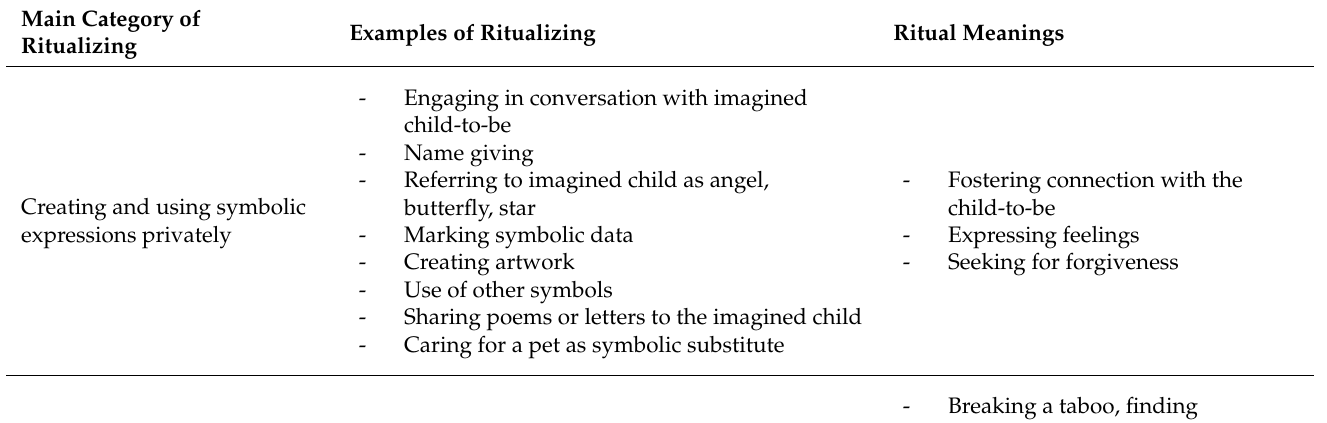
Table 2. Types of ritualizing abortion and ritual